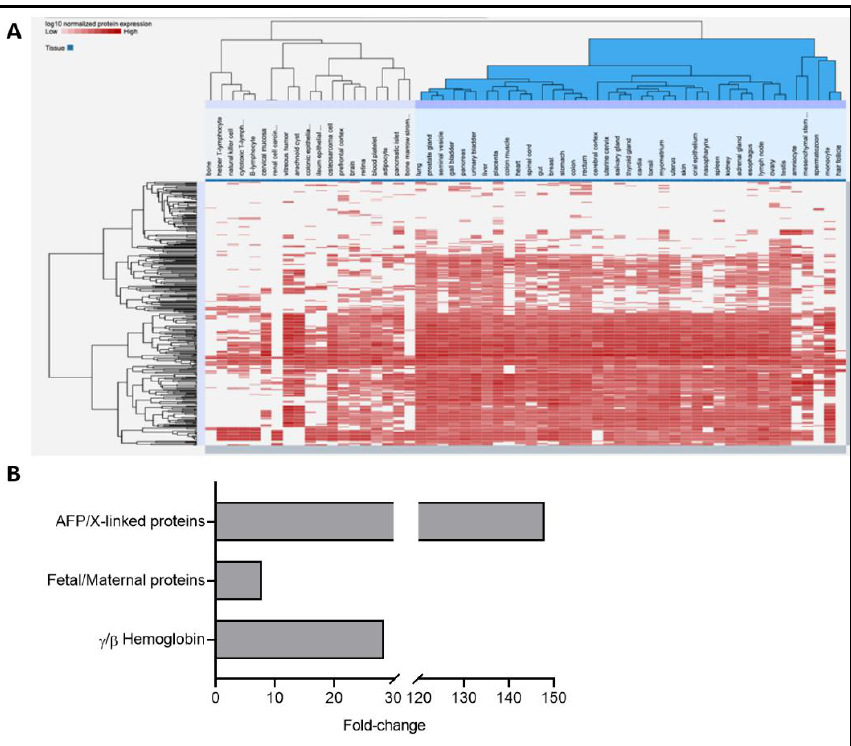
Figure 1. Confirmation of the fetal origin of AF. A heat map showing tissue representation in AF was obtained with the top 10% most abundant proteins from the AF proteomes. Analysis was per- formed as described in [35]. ( A ) Respiratory (lungs, oral epithelium), GI (esophagus, salivary gland, colon, rectum, gut, pancreas, stomach, liver, gall bladder), and urinary tract (kidney, uri- nary bladder) tissues were identified, along with male organs (e.g., spermatozoon, testis, seminal vesicles, prostate gland), as well as fetal and placental proteins. Amniocyte- and mesenchymal- stem-cell-specific proteins, and proteins from the brain and cerebral cortex, were also identified. ( B ) Those proteins predominantly or exclusively fetal were AFP, SI, LCT, CST3, SERPINA1, CP, TF, and ORM1; those X-linked were ARMCX4, BGN, CD99L2, CHRDL1, EFNB1, FLNA, IGSF1,